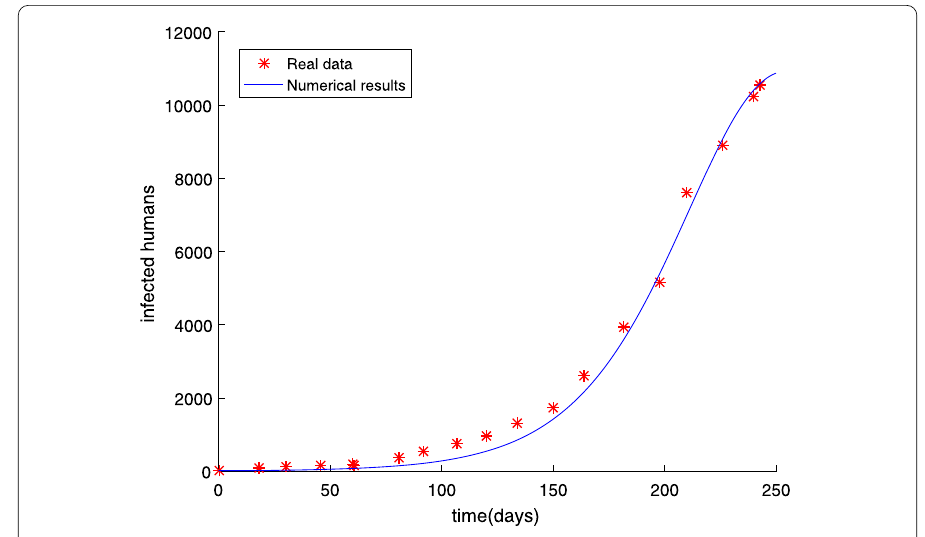
Figure 2 The number of Ebola infections I ( t ) in Guinea, Liberia, and Sierra Leone compared with the numerical results of fractional order system (9) obtained by the MGAM method and g ( U ∗ ) = 0.4146